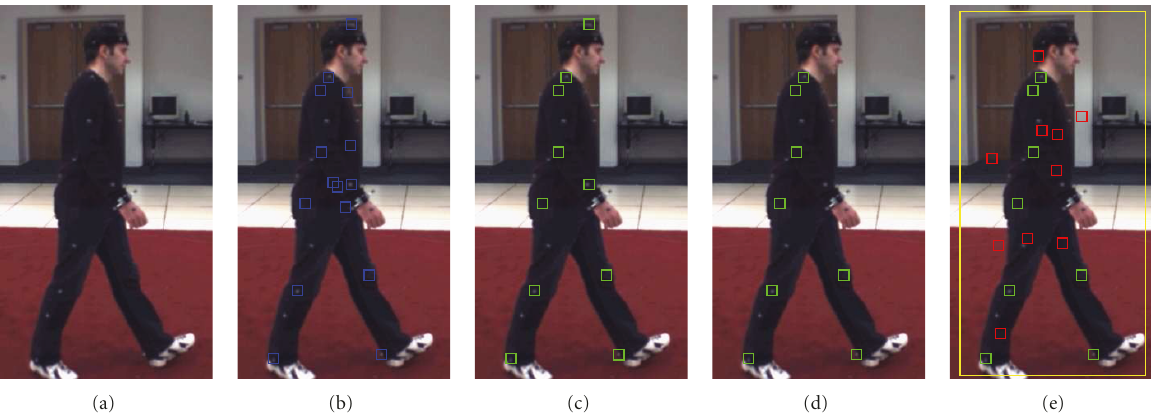
Figure 5: Synthetic data generation process. Since the reflective markers are not distinguishable in the original RGB image (a), the sets { D n } N C n = 1 are generated from the 3D locations provided by the MoCap system. First, for a given view corresponding image (b), and those a ff ected by body auto-occlusions are removed (c). Then, the marker detection algorithm Γ is applied: some markers are missed due to the detection ratio (d), and a number of false measurements are generated (e). Finally, an amount of Gaussian noise with variance σ 2 Γ is added simulating the position estimation error.